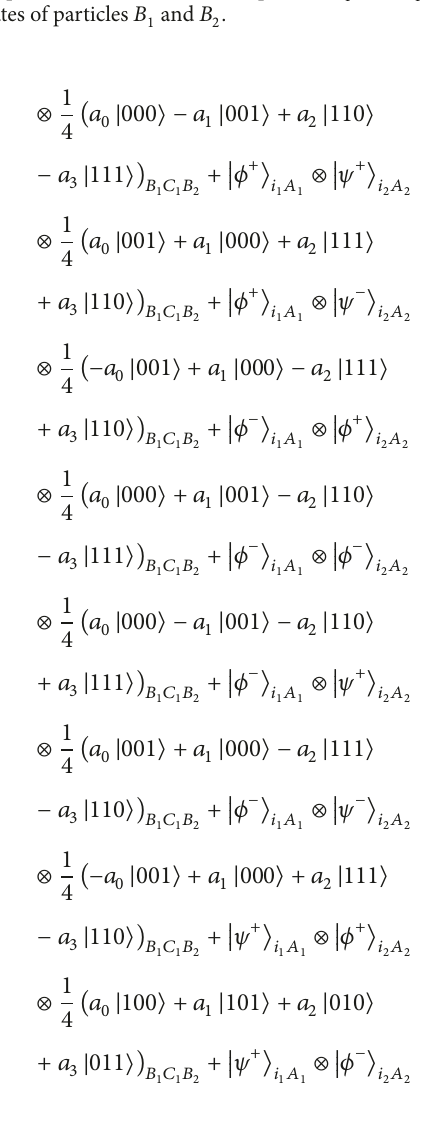
Figure 1: (a) shows the preparation and distribution of entangled states; (b) expresses the measurement of particles 𝑖 1 and 𝐴 1 , 𝑖 2 and 𝐴 2 ; (c) shows the measurement of particle 𝐶 1 ; (d) shows the unitary operation for states of particles 𝐵 1 and 𝐵 2 .